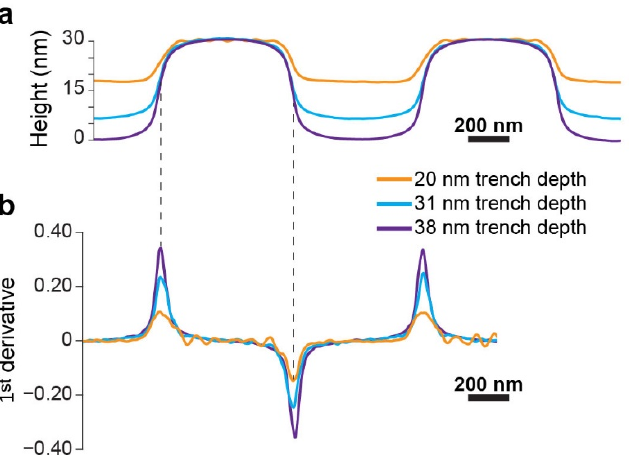
Figure 6. ( a ) Overlay of the average SFM film profile for different trench depths for plateau/trench widths of 640/640 nm. Film profiles were offset to overlap at the top of the plateau film to facilitate visual comparison. ( b ) First derivative curves of the film profiles shown in ( a ).